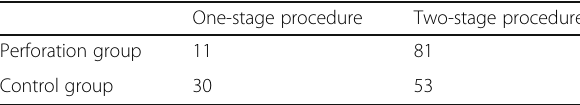
Table 5 Fisher ’ s exact test: surgical strategy dependent on membrane perforation ( p =